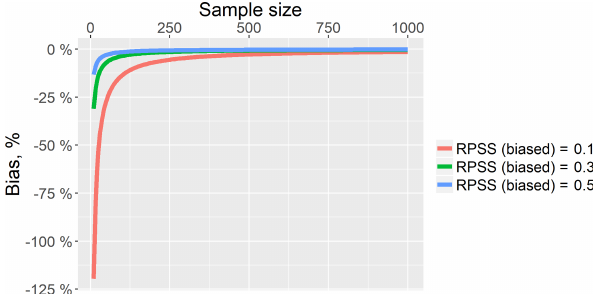
Figure 12. Negative bias of the RPSS estimate in dependence on the ensemble size and the RPSS